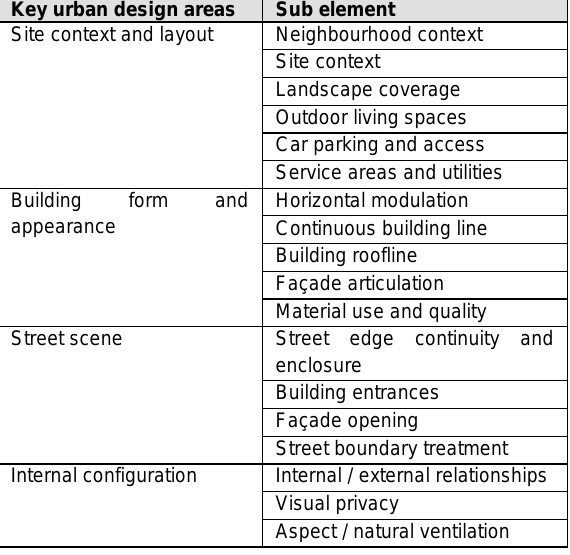
Table 1. Urban design assessment criteria Source: Ministry for the Environment’s Medium-Density Housing: Case Study Assessment Methodology (2012) Key urban design